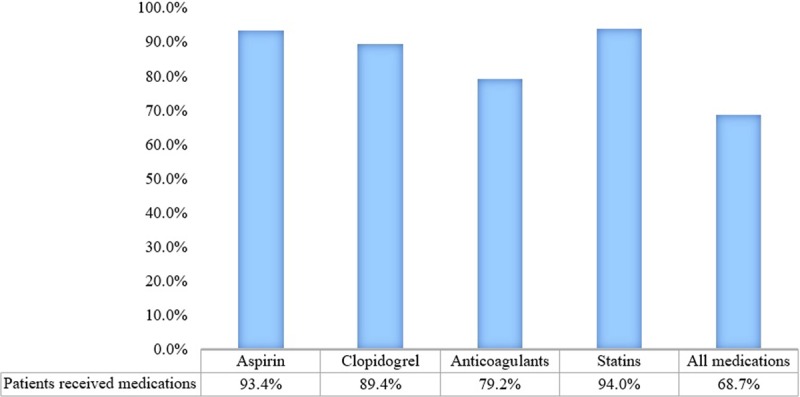
The level of adherence in prescribing individual medications (aspirin, clopidogrel, anticoagulants, statins) and all-combined medications in non-reperfused STEMI patients during hospitalization.